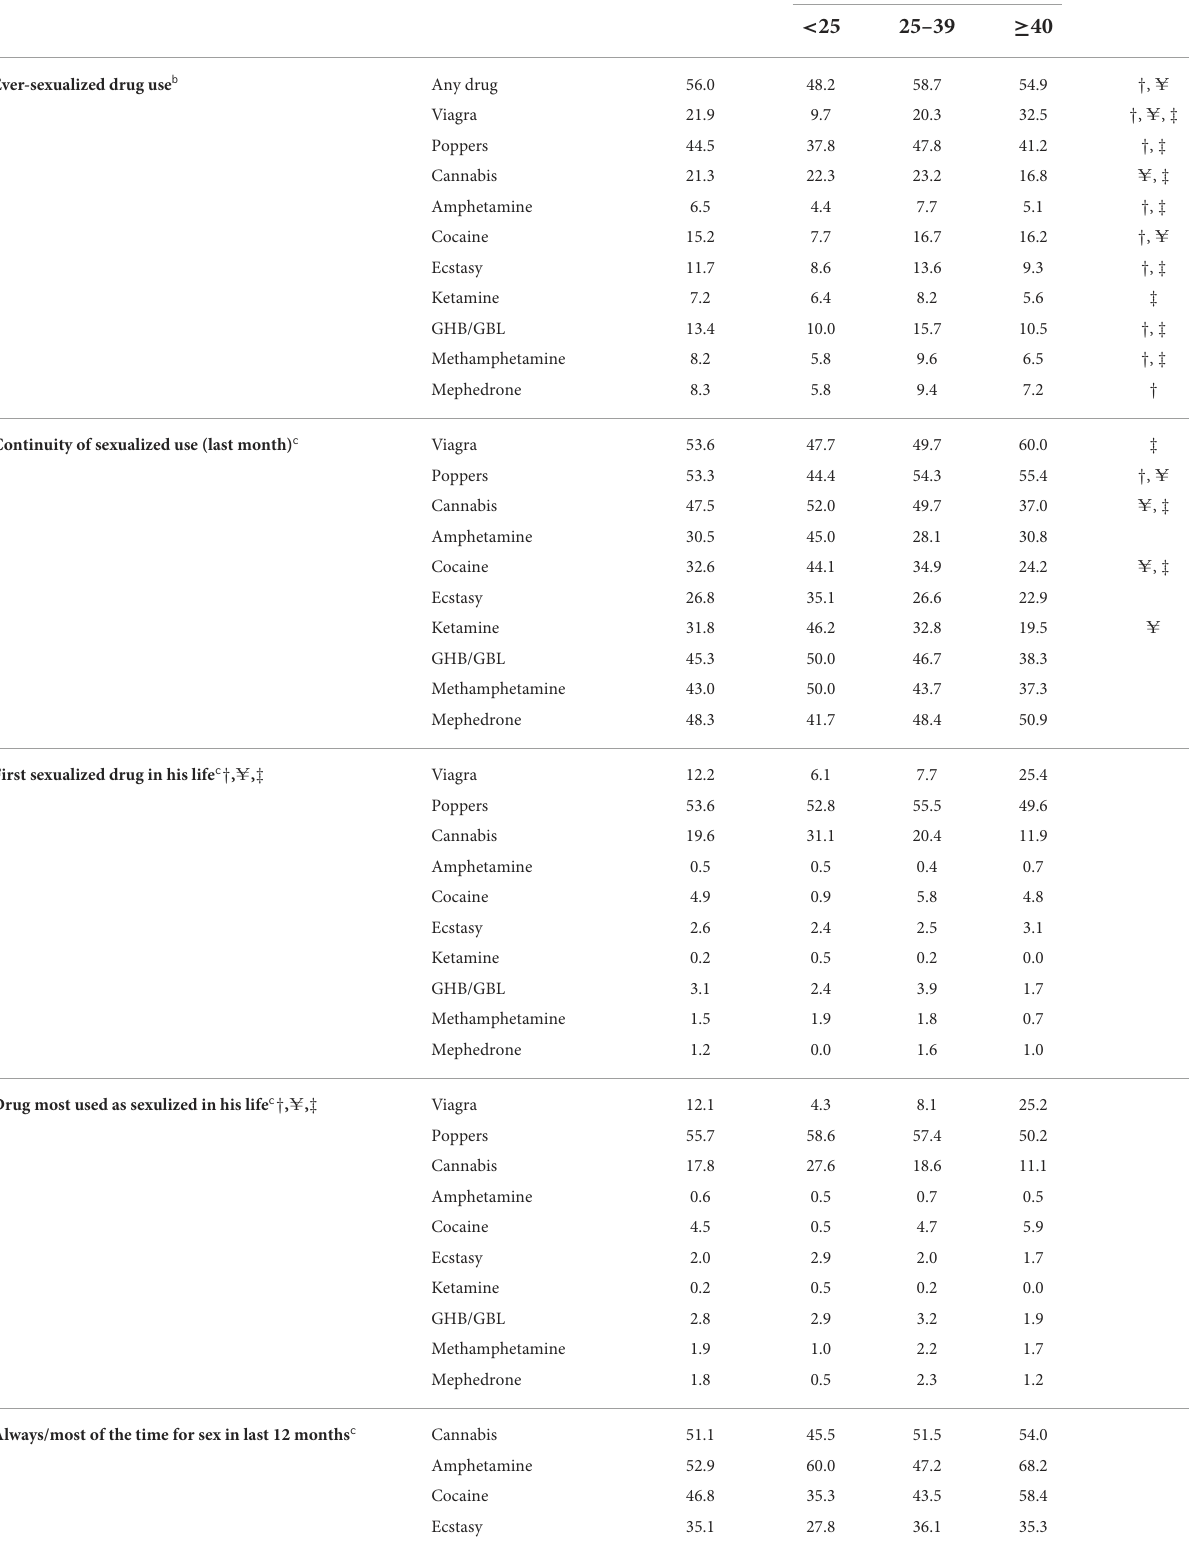
All Age P -value < 25 25–39 ≥ 40